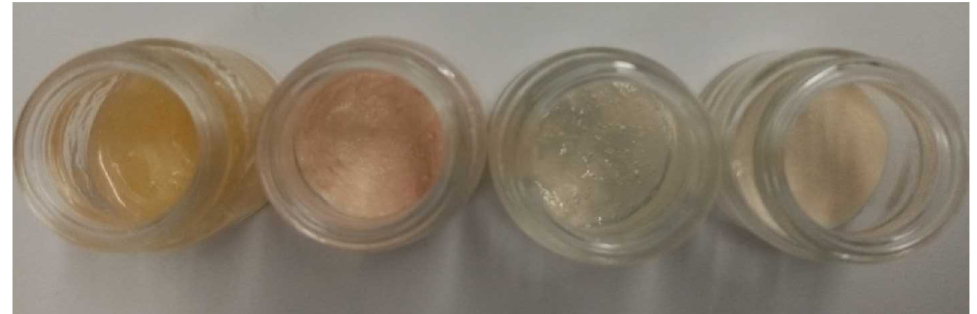
Figure 3. Cosmetic formulations from left to right: peel-off mask (DES 1); lip balm (DES 2); water- soluble mask (DES 3); cream (DES 4).